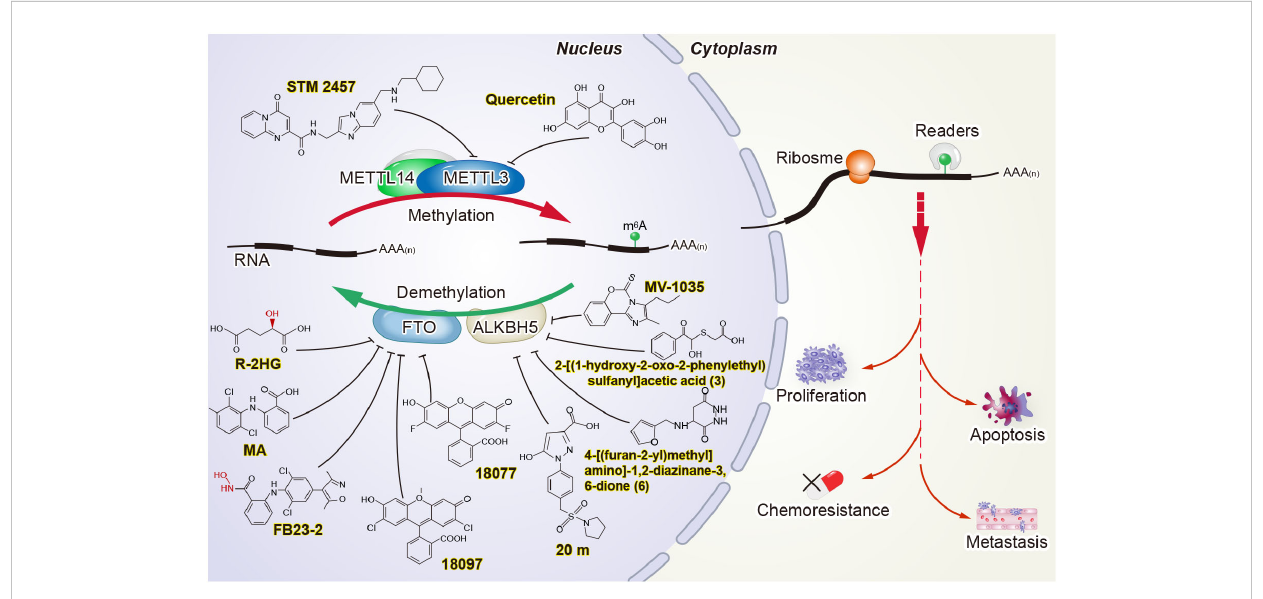
FIGURE 2 Potential strategies for targeting m6A in